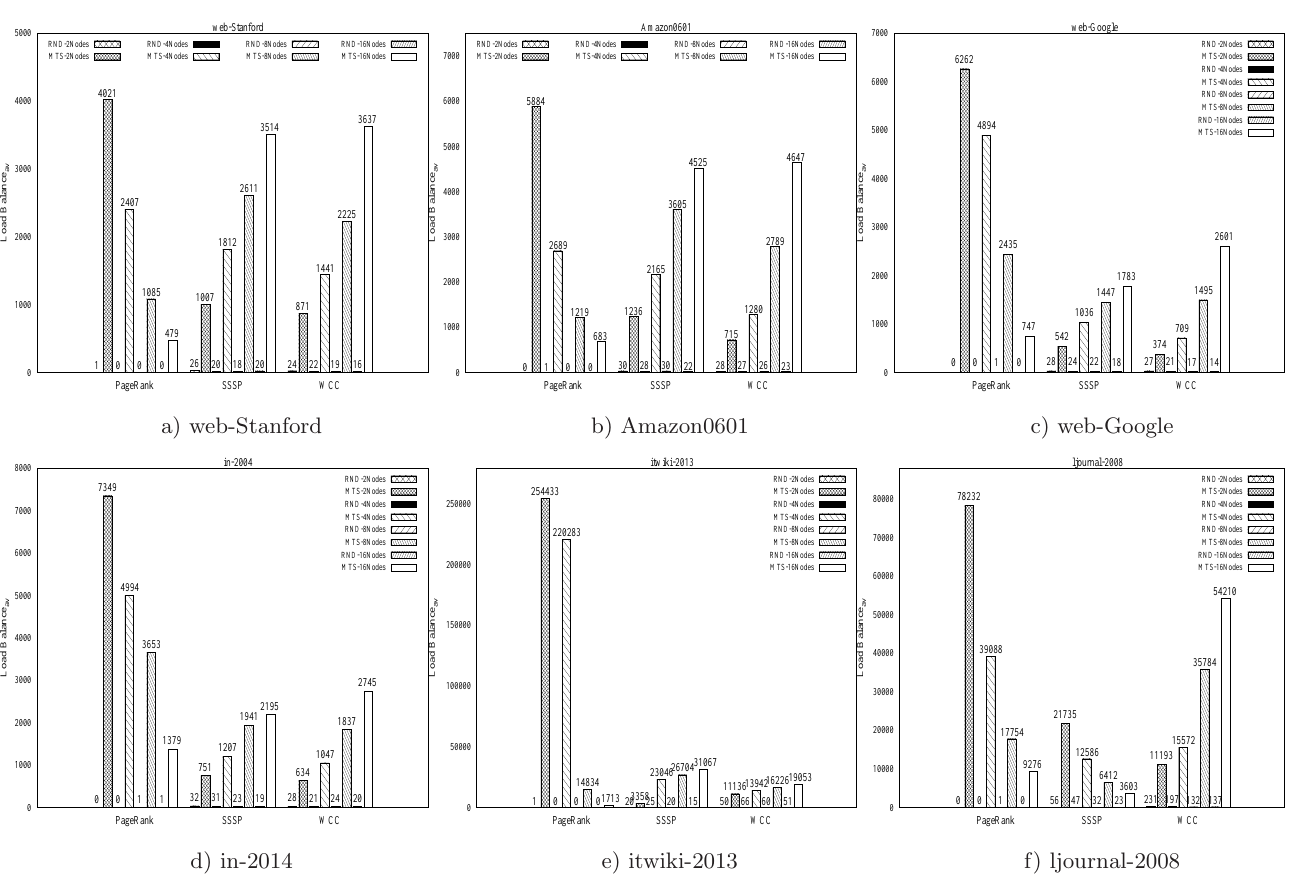
Figure 5. Load Balance av performance metric for web-Stanford, Amazon0601, web-Google, in-2004, itwiki-2013 and ljournal-2008